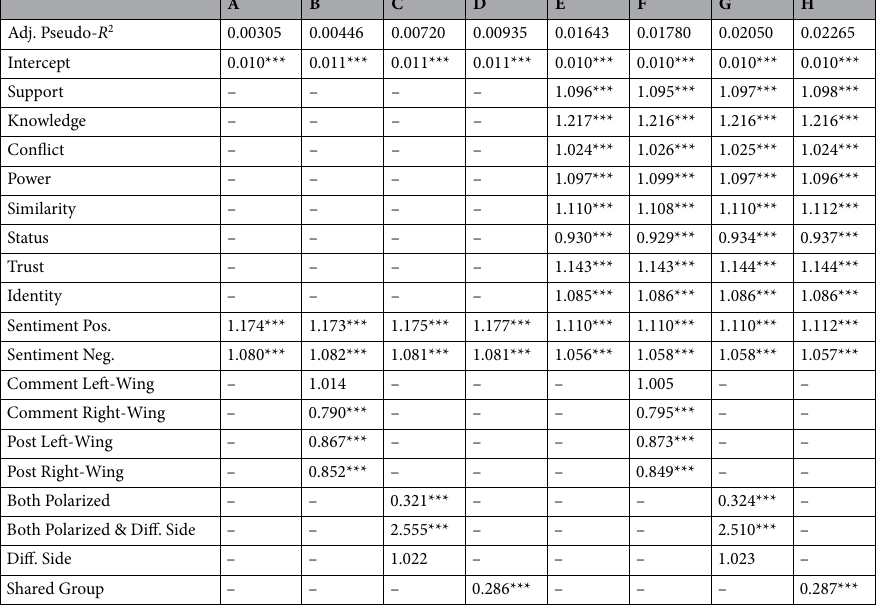
Table 2. Odds ratios obtained by logistic regression. Each column corresponds to a model with a specific set of variables. A description of each confounder is given in Table 3. We indicate with asterisks the statistically significant correlations (with one, two or three asterisks corresponding to P < 0.05, P < 0.01 and P < 0.001 respectively). P -values are corrected according to the Benjamini-Hochberg procedure 29 , to reduce the chance of spurious correlation emerging because of the high number of factors we consider.